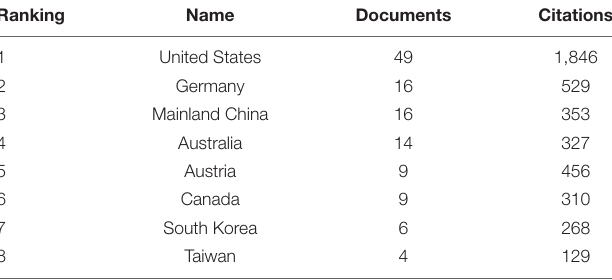
TABLE 4 | Countries (regions) with more than four documents and their